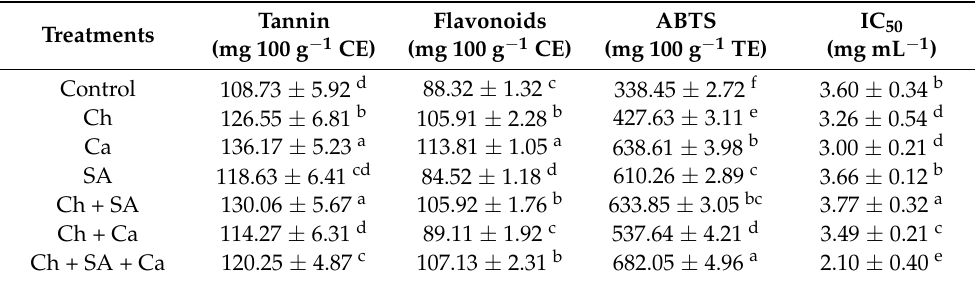
Table 3. Effects of preharvest application of natural elicitors on phytochemical contents and antioxi- dant activity of “Barhi” fruit at